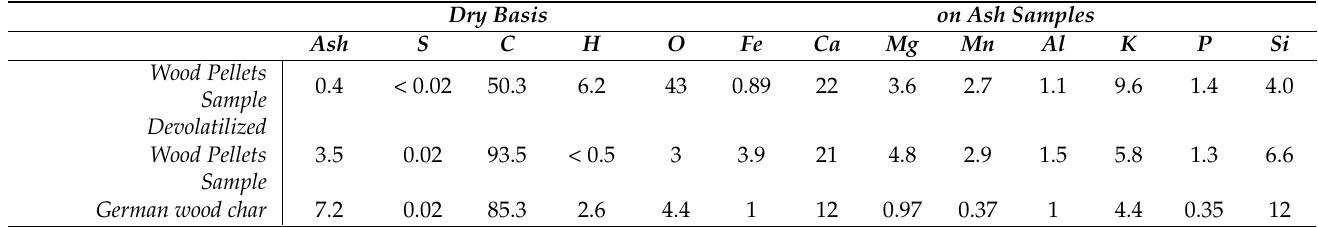
Table 2. Fuel analysis of the pellets and devolatilized pellets used in the experiments. Samples